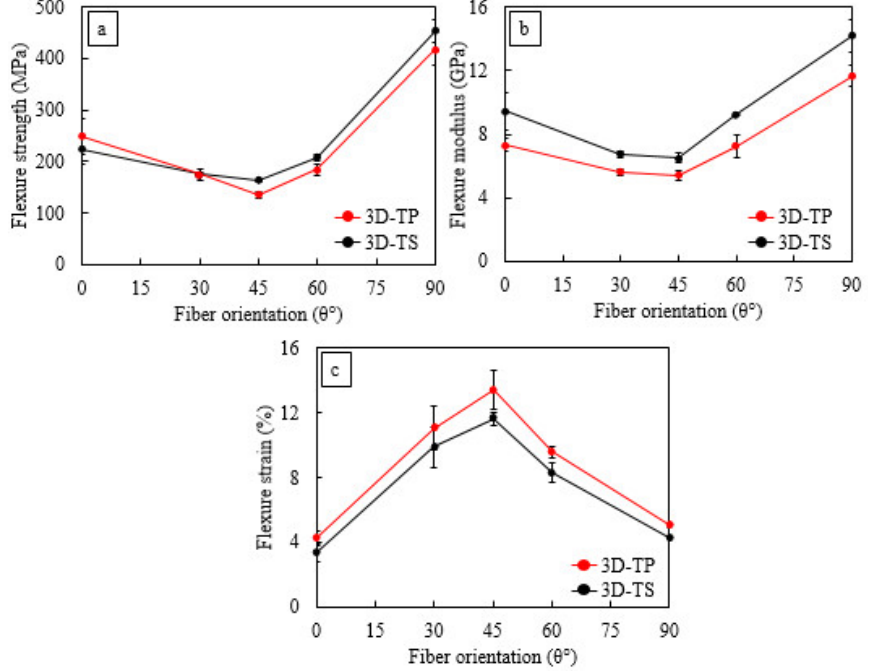
Figure 5. Variation of flexure strength, modulus and failure strain as a function of fibre orientation in 3D-FRC. ( a ) Flexural strength, ( b ) Flexural modulus and ( c ) Flexural strain.